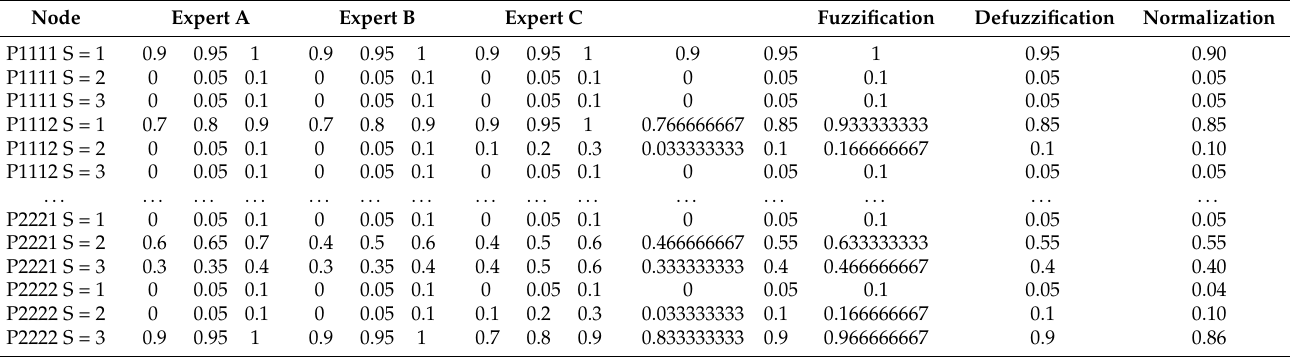
Table 4. Investigation and analysis results for node